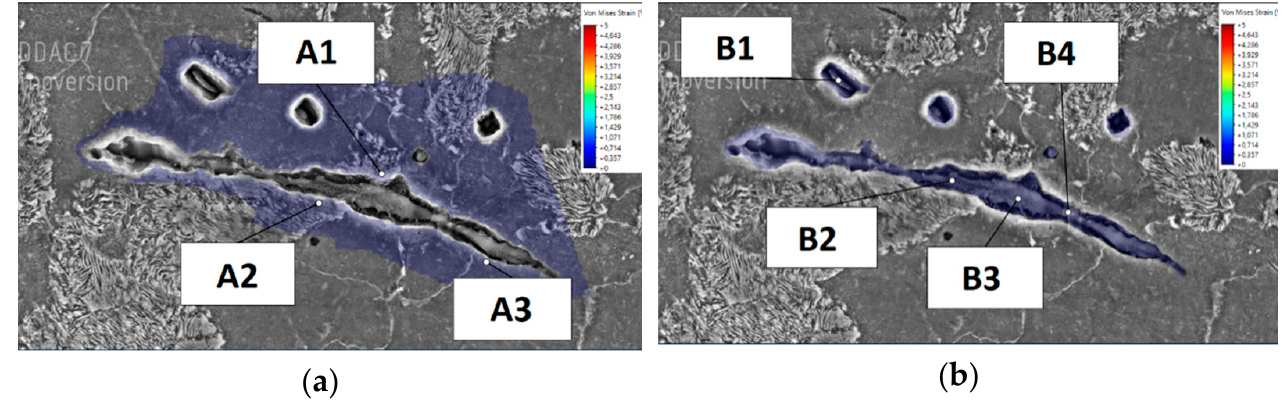
Figure A8. Marking and numbering of measuring points ( a ) around non-metallic inclusions; ( b ) within non-metallic inclusions. The diagram in Figure A9 shows that the intensity of micro deformation is significantly higher compared to macro deformation at the points far from the pearlite grains.